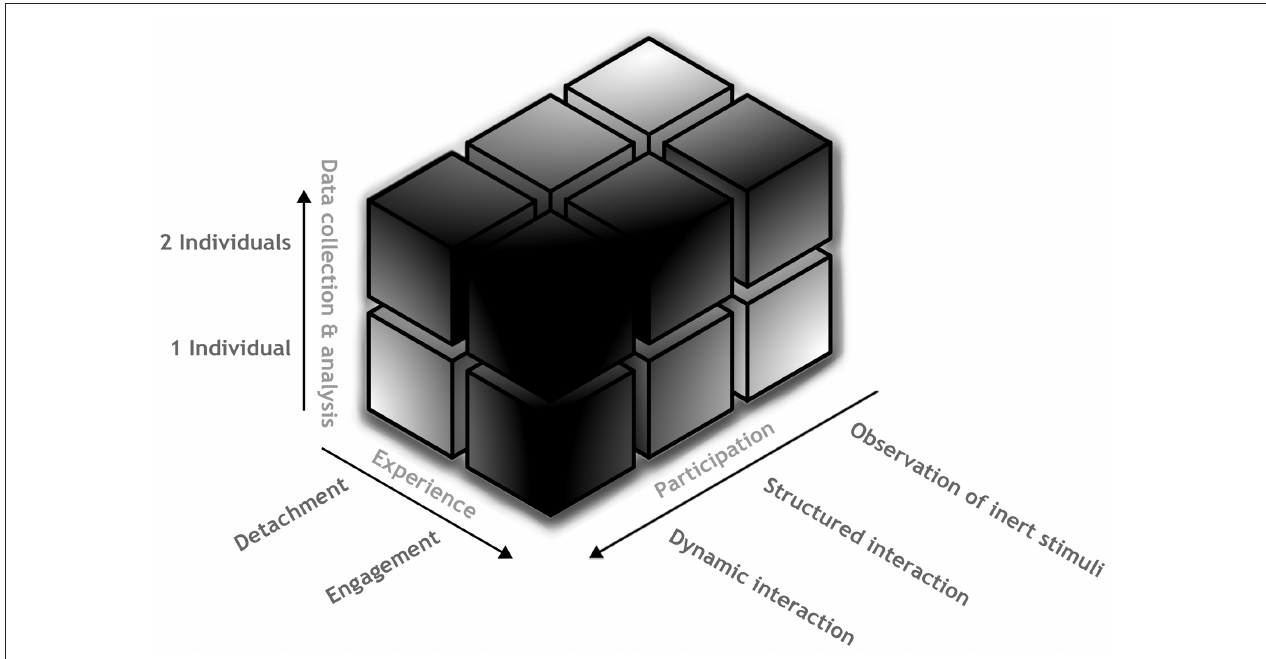
FIGURE 1 | Depiction of the experimental landscape of research in social neuroscience. More intense shades of gray indicate areas of the landscape, which have been left largely unexplored, thus, representing the “dark matter” of social neuroscience.